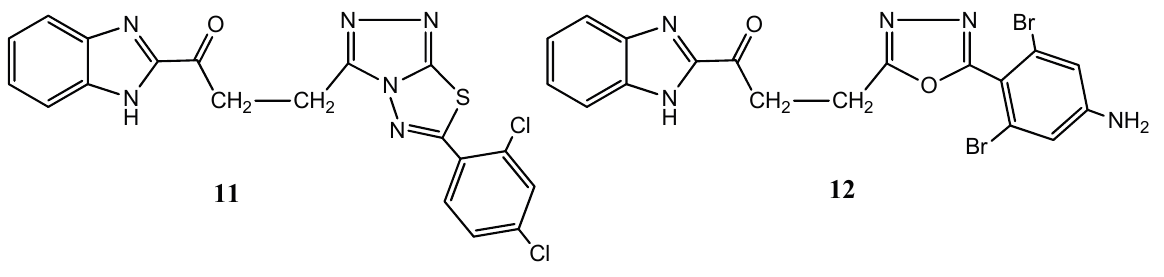
Figure 7. Chemical structure representation of synthetized benzimidazole hybrid heterocycles with superior selectivity for leukemia cell lines ( 11 ) and for non-small cell lung cancer cell lines ( 12 )